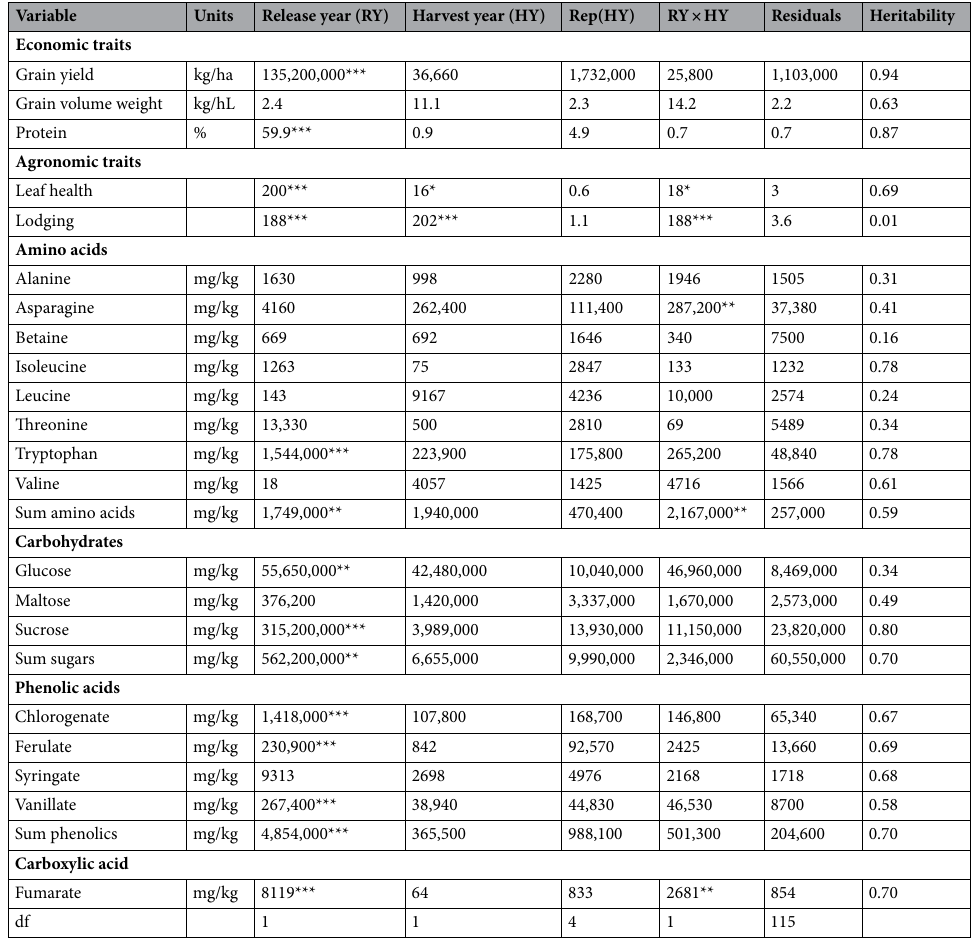
Table 2. Analysis of variance (mean squares) and broad sense heritability of economic and agronomic traits and metabolites in whole wheat flour from modern and historical wheat varieties. df degrees of